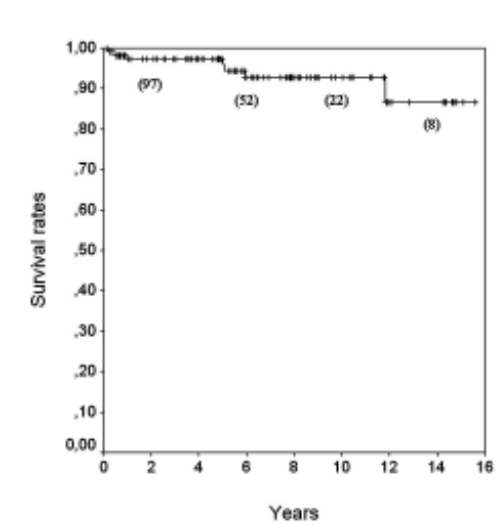
Fig. 5 - Curva de sobrevida actuarial livre de reoperação. () indivíduos sob